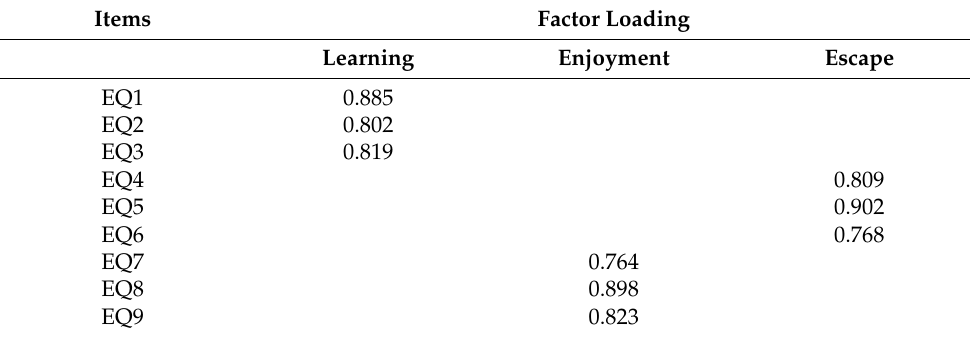
Table 5. Rotating component matrix of the experience quality.